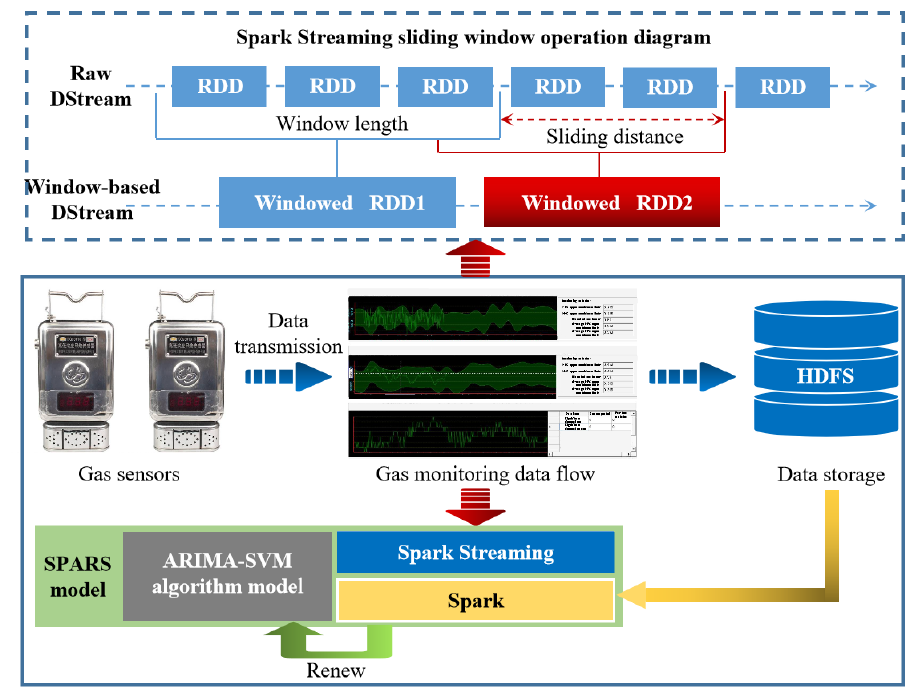
Figure 4. Gas framework structure diagram of Spark Streaming.